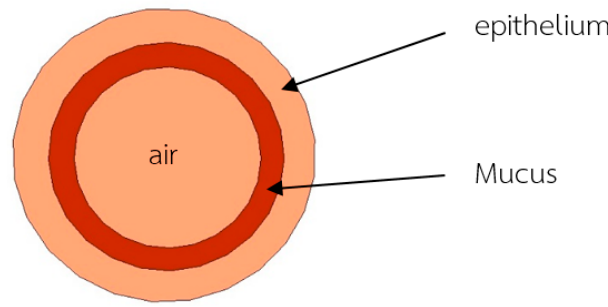
Figure 2. A cross-section of the trachea.